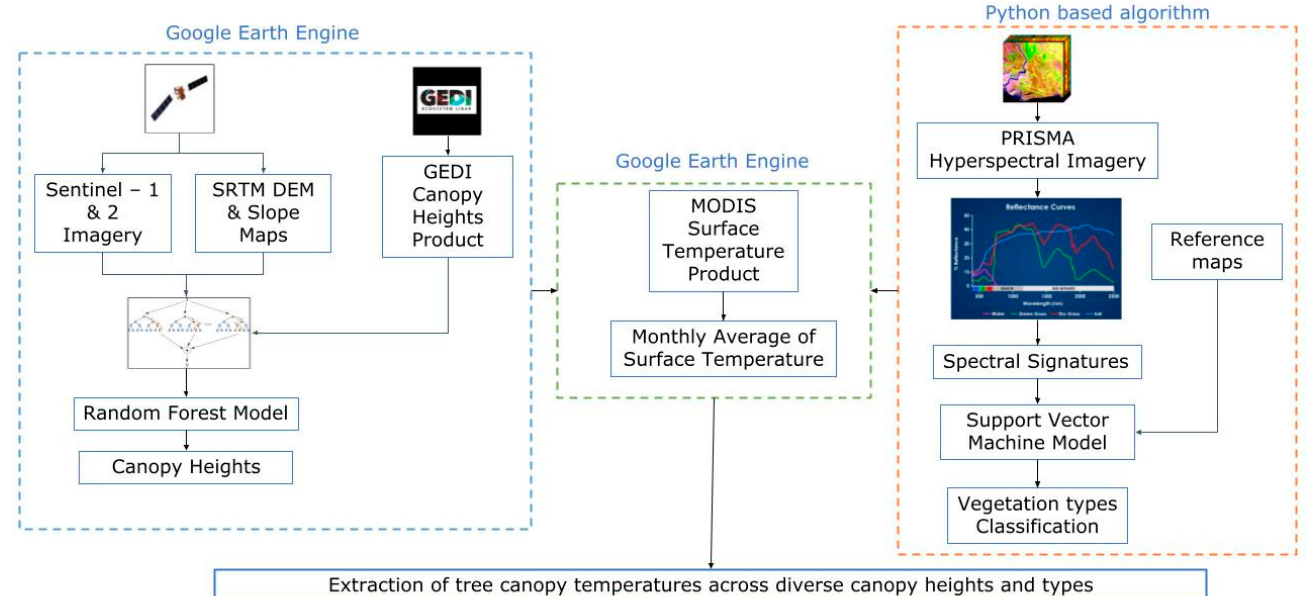
Figure 2. Concept flow chart of canopy height estimation, canopy temperature extraction, and veg- etation